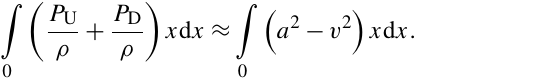
Figure 5. Ratio of axial induction at the rotor, a , to value in the far wake, a ∞ . p = 0 . 05; (cid:5) . p = 0 . 10; dashed line. Note that the x axis is